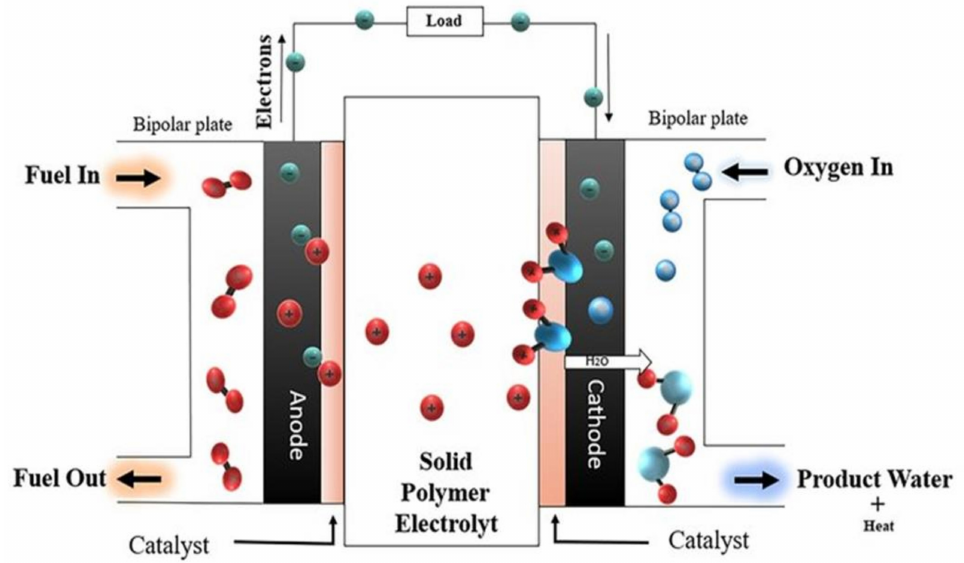
Figure 1. PEMFC operation system